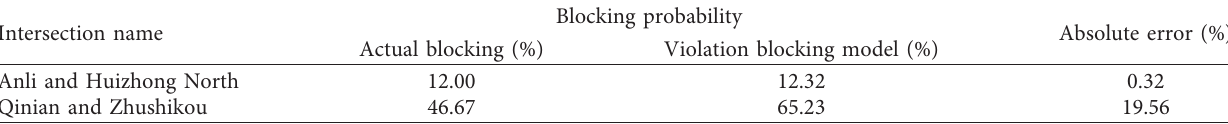
Table 3: Cross intersection diagonally at the left-turn phase: model error.